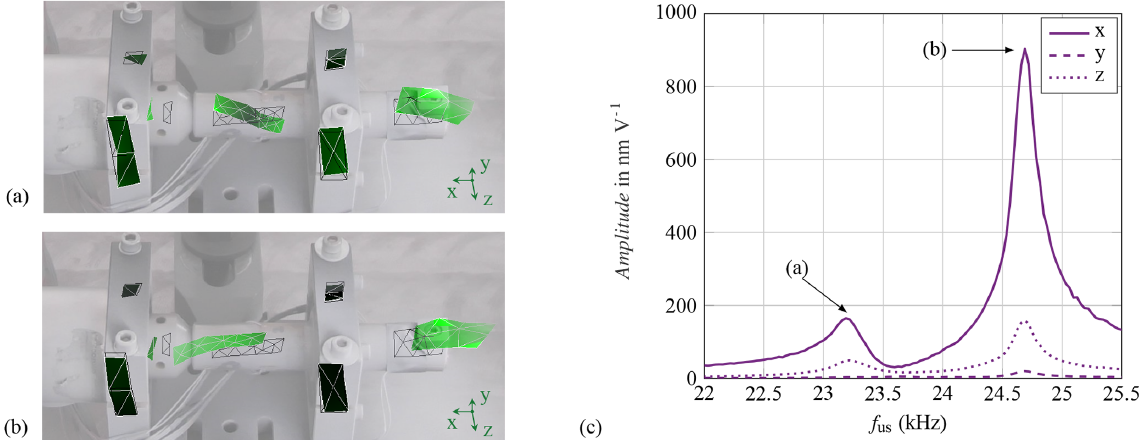
Figure 8. Measured mode shapes for two resonant frequencies: the bending mode at 23.2kHz (a) and the longitudinal mode at 24.7kHz (b) . The corresponding transfer function in three spatial directions (c)